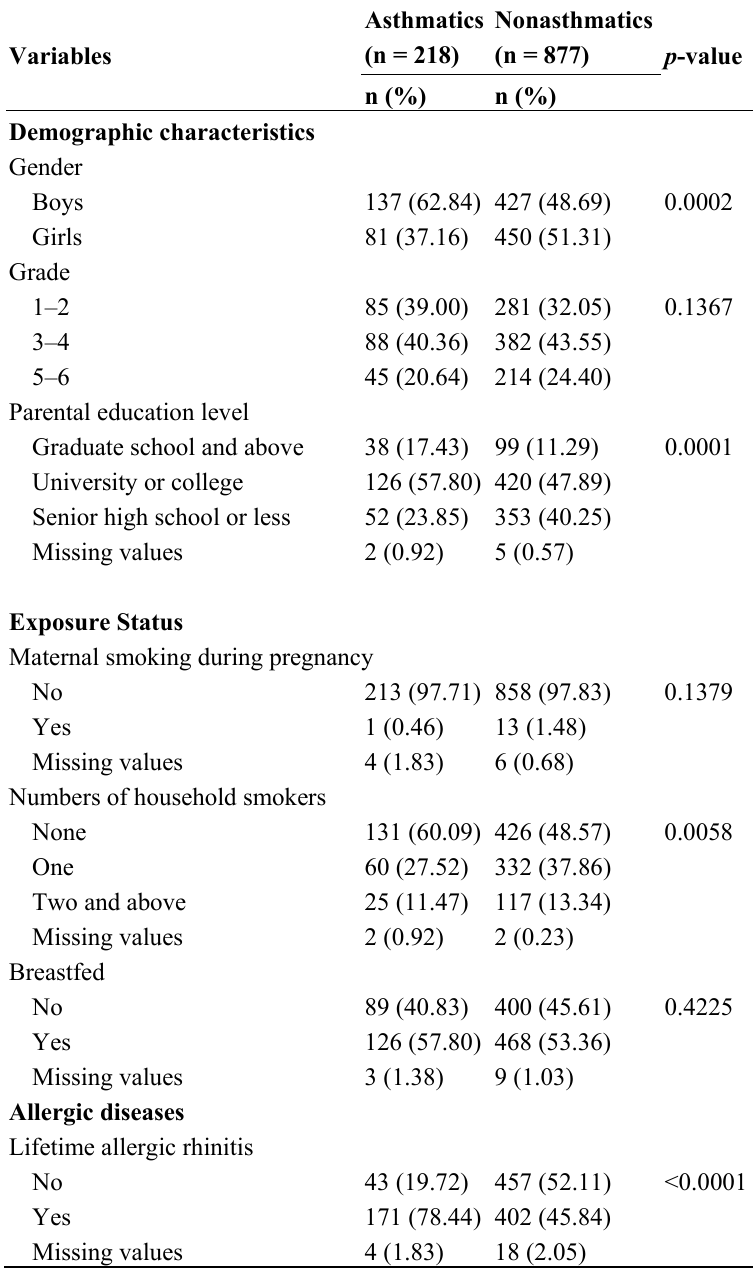
Table 1. Selected characteristics of participants by asthma